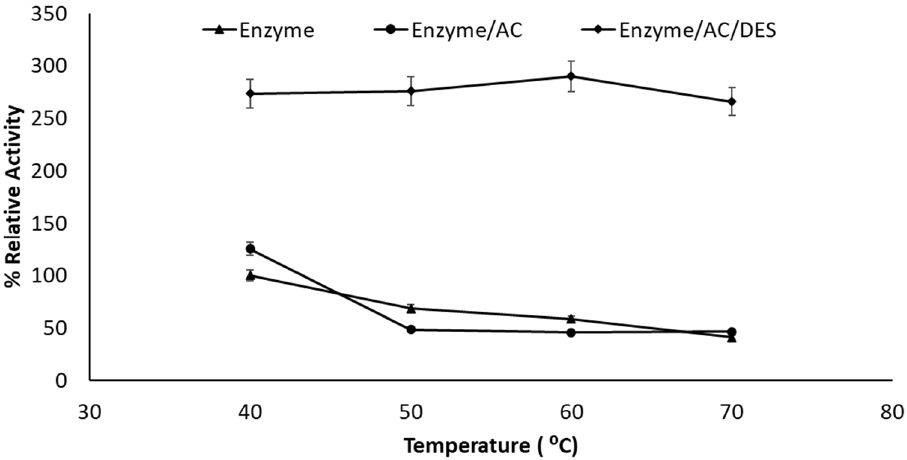
Figure 6. Immobilized and free Lipase activities at various incubation temperatures (2 h incubation time and 1:1 DES molar ratio).